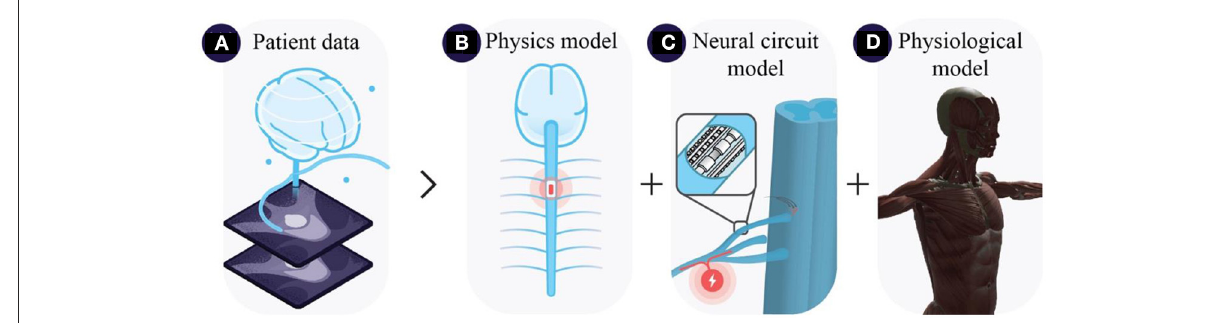
FIGURE1 Three-layer neurostimulation modeling architecture, illustrating (A) extraction of patient data from monitoring systems e.g., MRI scans, (B) approximation of electric field distributions coupled with (C) neural circuit models, and (D) physiological end-organ models e.g., musculoskeletal